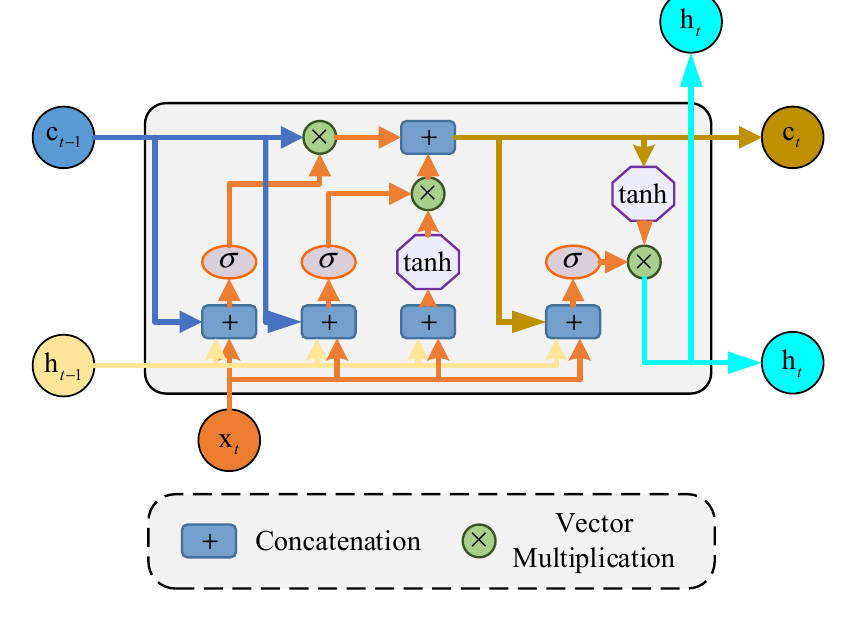
Figure 2. Structure of LSTM cell.